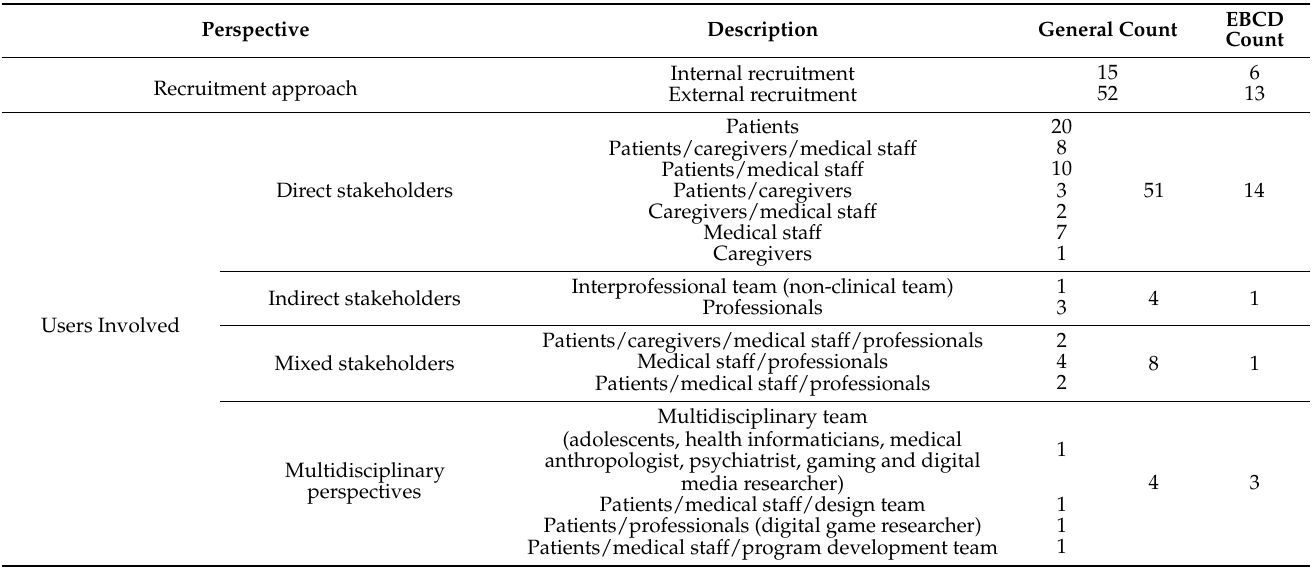
Table 10. Summary of the study’s diversity